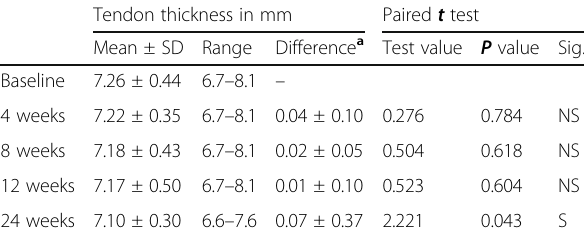
Table 2 Comparison between baseline tendon thickness and its follow-up at 4 weeks, 8 weeks, 12 weeks, and 24 weeks Tendon thickness in mm Paired t test Mean ± SD Range Difference a Test value P value